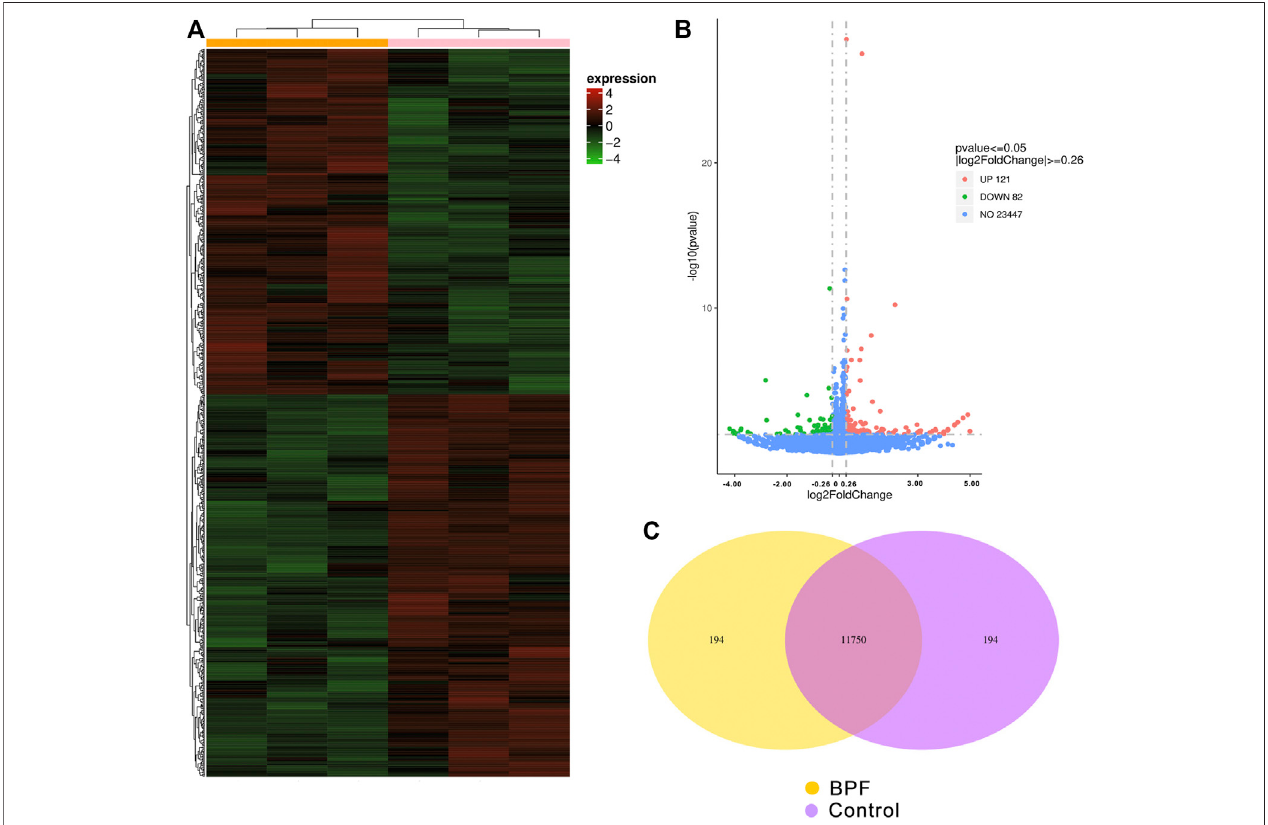
FIGURE 3 | Differential expression patterns of mRNAs between control and BPF-exposed RAW264.7 macrophages. (A) The cluster heat map. (B) The volcano mapofallthesequencedgenesfromthesamples( p < 0.05and|log2(foldchange)| > 0.26). (C) Venndiagramofco-expressedgenesbetweencontrolandBPF-exposed RAW264.7